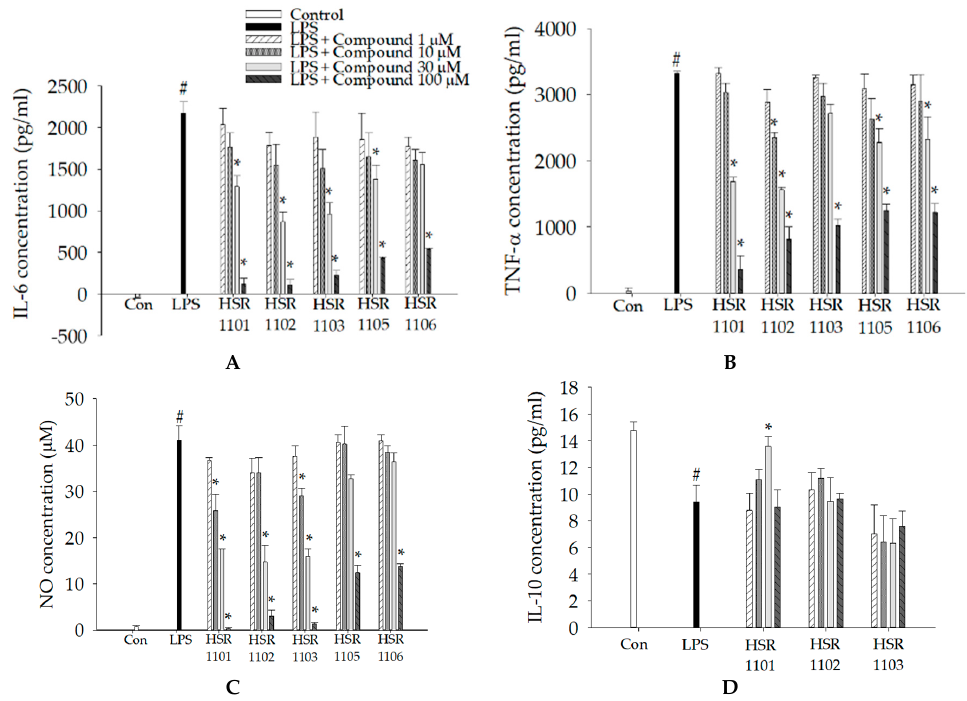
Figure 3. Effects of HSR1101~1103, 1105, and 1106 on pro- and anti-inflammatory mediators in lipopolysaccharide (LPS)-treated BV2 cells. BV2 cells were co-treated with 1 µg/mL LPS and a series of concentrations of tested compounds for 24 h. Culture media were then analyzed for interleukin (IL)-6 ( A ), TNF- α ( B ), NO ( C ), and IL-10 ( D ) levels, as described in the Materials and methods section. Data are expressed as mean ± SEM of at least three independent experiments. # p < 0.05 and * p < 0.05 vs the vehicle-treated control and LPS-treated groups, respectively. Con, control; LPS, lipopolysaccharide; IL, interleukin; TNF- α , tumor necrosis factor-alpha; NO, nitric oxide. Table 1. IC 50 values of isoquinoline-1-carboxamide derivatives inhibiting IL-6, TNF- α , or NO production in LPS-treated BV2 microglial cells. IC 50 Value a Pro-Inflammatory Mediators